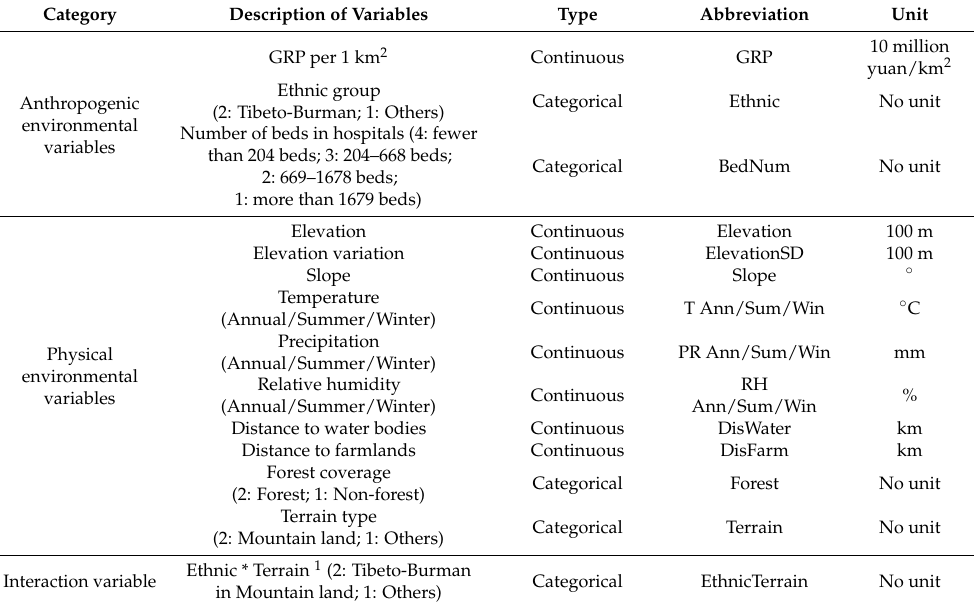
Table 2. Summary of environmental variables used for analysis in this